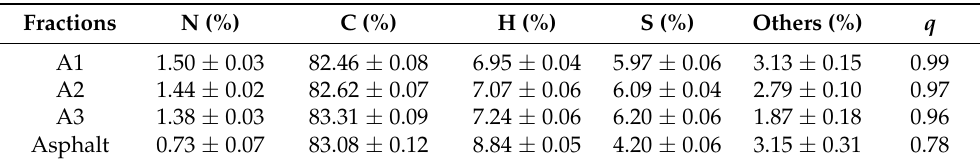
Table 4. Mass percentage of elements from EA (CHNS mode) and the calculated C/H atomic ratio ( q ) for extracted asphaltenes (A1, A2 and A3) and